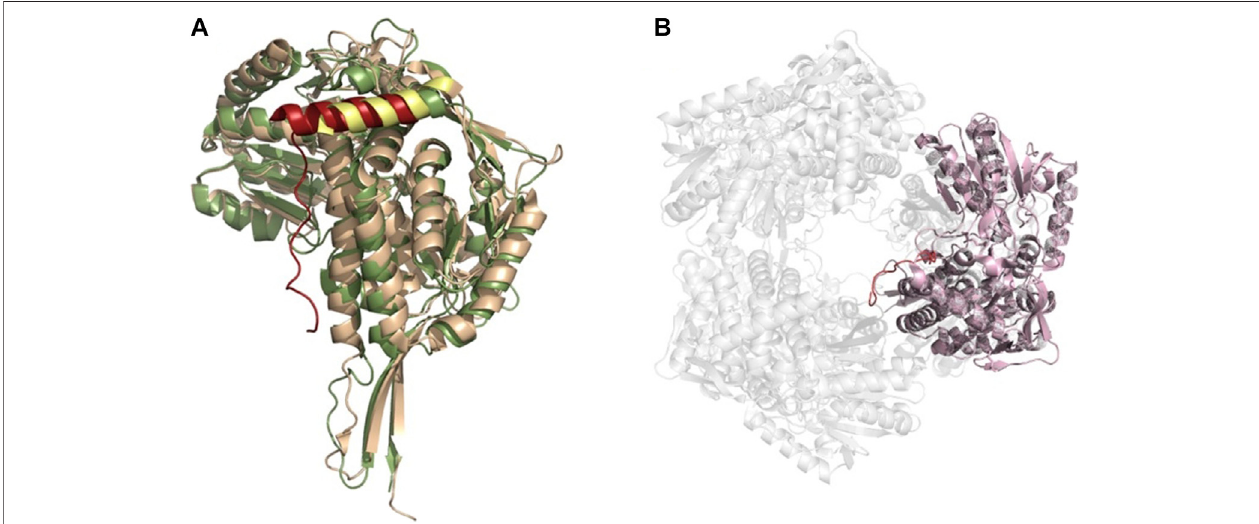
FIGURE8| ALDH hexamericstructure (A) Superimposition ofthemonomersofyeastALDH4A1 (orange)and TtP5CDH (green) (PDB:4OE6,2BHQ,respectively), demonstrating the N-terminal extension equipped with an alpha helix in hexamer forming ALDHs. Extension is shown in red for TtP5CDH and yellow for yeast. (B) The hexameric assembly of TtP5CDH (PDB: 2BHQ) with the N-terminal loop (red) penetrating the pore formed by the